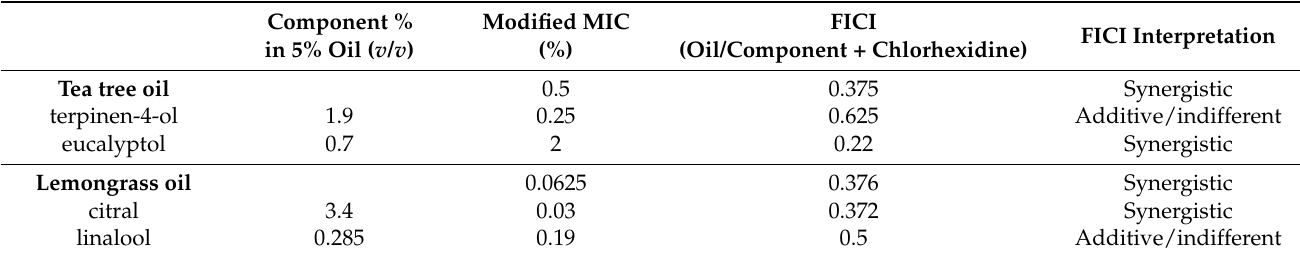
Table 1. Activities of essential oil components alone and in combination with